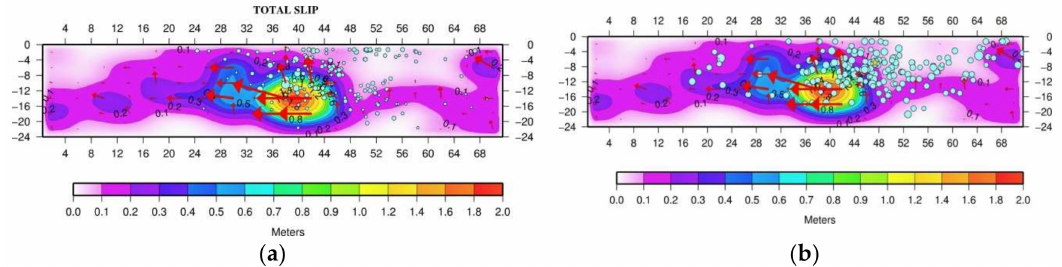
Figure 19. As in Figure 17, blue circles show relocated foreshocks (20 April 2018–25 October 2018) ( a ) and first 5-day aftershocks ( b ). Star outside the main slip (asperity) area and to the north of it is the epicenter of the largest aftershock (30 October 2018, M w = 5.4, Figure 1b) of the entire aftershock